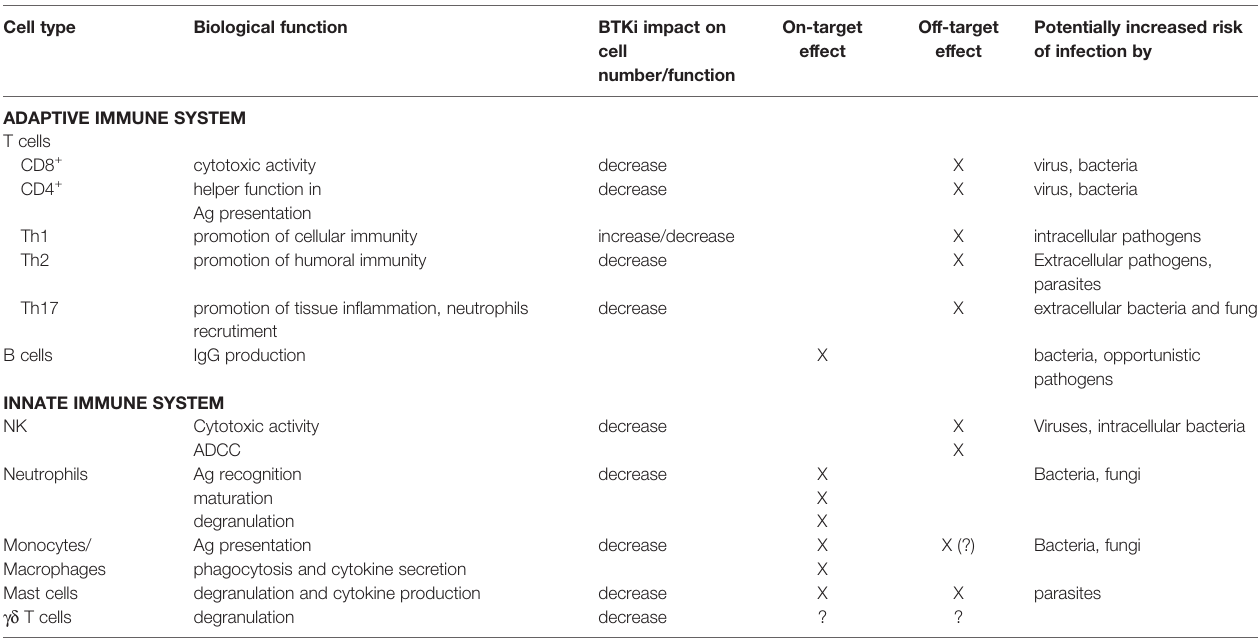
TABLE 2 | Potential impact of treatment with BTK inhibitors on infectious susceptibility. Cell